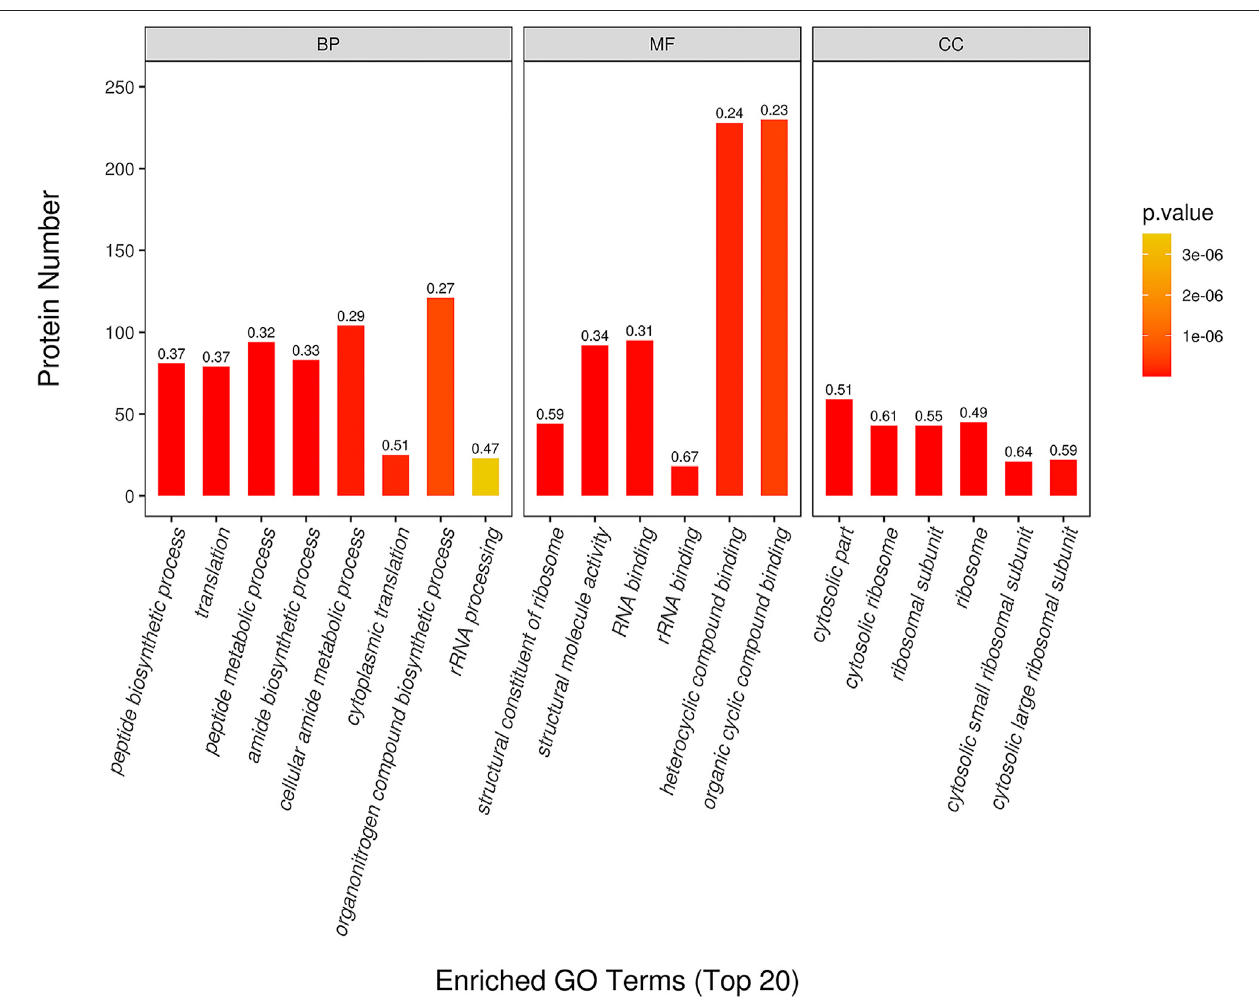
FIGURE4| GOenrichmentofDEPsinCPTandMC.The x -axisrepresentstheBiologicalProcess(BP),CellularComponent(CC),andMolecularFunction(MF).The y -axis represents gene number, the numbers represent the enrichment factor of DEPs ratio.